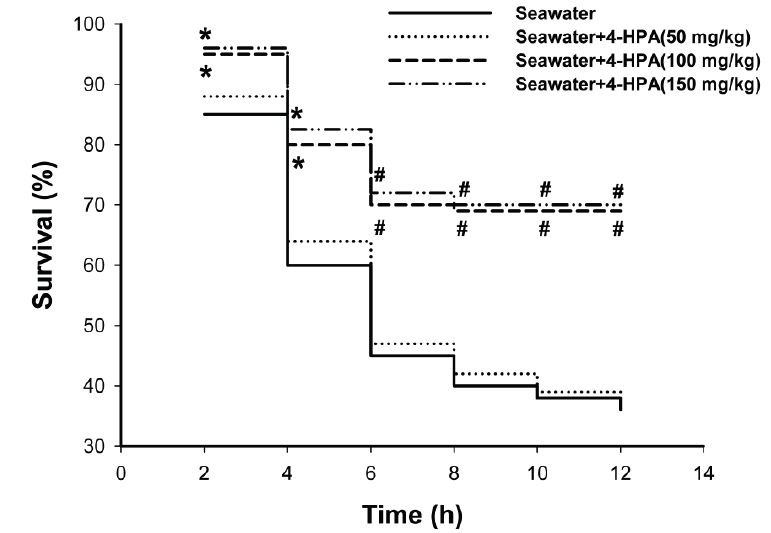
Figure 1. Effects of 4-hydroxyphenylacetic acid (4-HPA) on seawater instillation-induced mortality in rats. Drowning model rats were prepared with or without different does of 4-HPA (50, 100 or 150 mg/kg body weight, i.p.). 4-HPA was administered after seawater instillation for 10 min. The mortality of rats were recorded at 2, 4, 6, 8, 10, and 12 h after seawater instillation in each group ( n = 20). * p < 0.05 vs. seawater group, # p < 0.01 vs. seawater